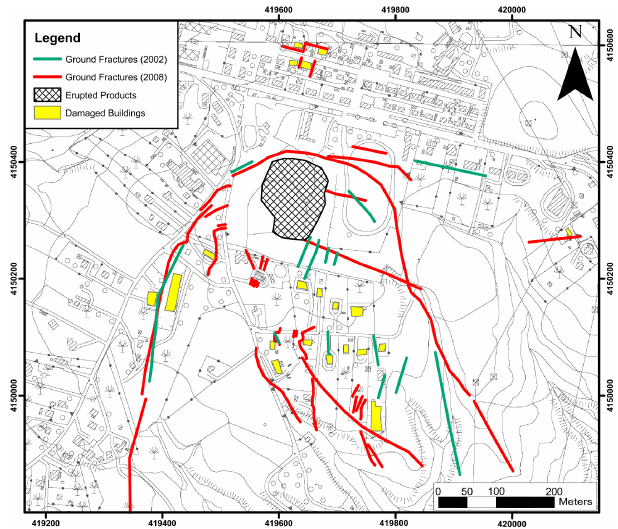
Figure 2. Cartographic extract with the location of the major frac- tures (in red) detected on the ground and the damaged structures (in yellow) related to the paroxysmal event of 2008. In green are frac- tures detected in 2002. The base map is Carta Tecnica Regionale 2008 (CTR). The reference system is WGS 84/UTM zone